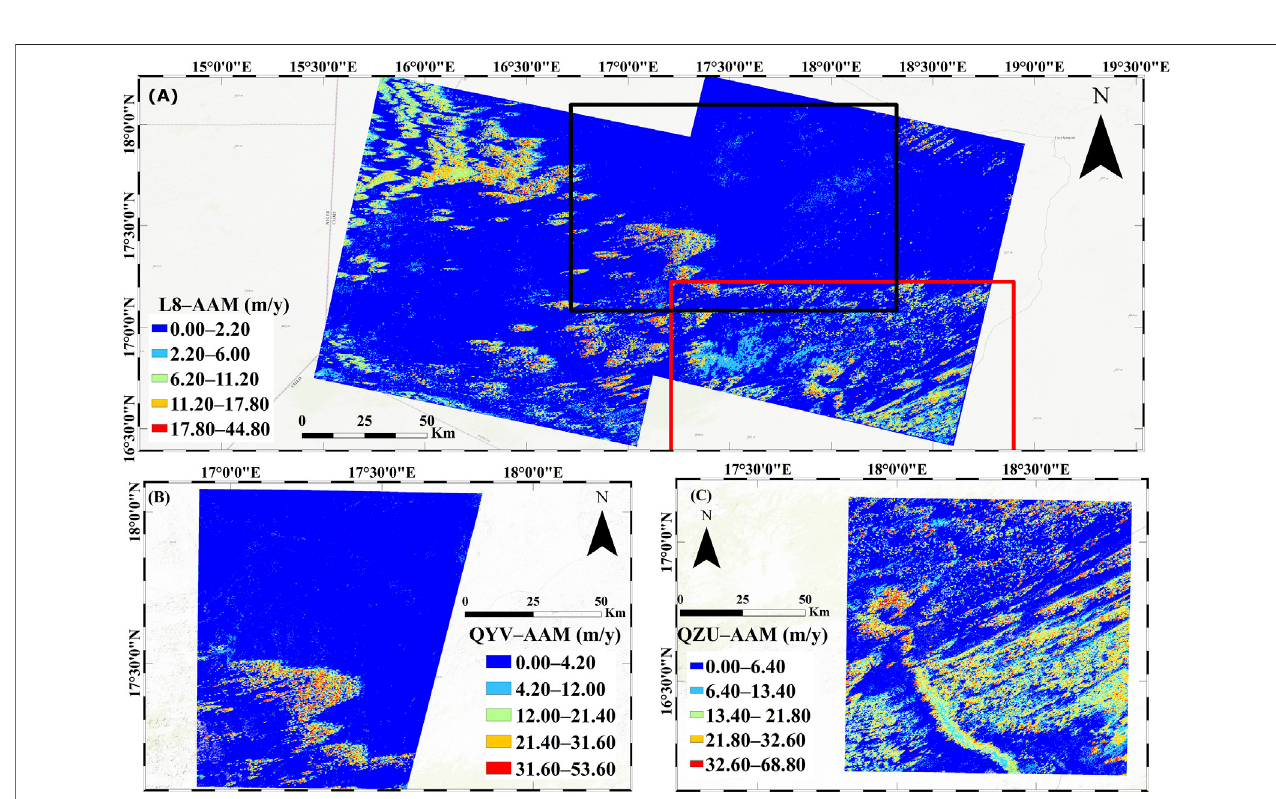
FIGURE 4 | Average annual magnitudes of dune migration for Landsat-8 (A) and two Sentinel-2 images: TR33QYV (B) and TR33QZU (C) . The black and red polygons in panel (A) denote the coverage of TR33QYV and TR33QZU, respectively. The background is light gray canvas © using Esri ArcMap 10.3.